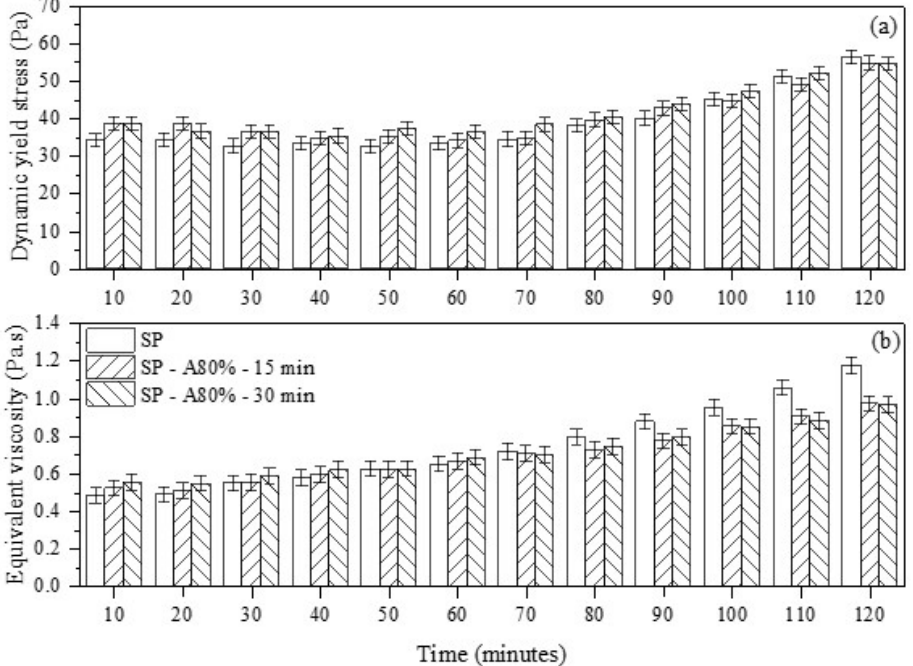
Figure 9. Dynamic yield stress (a) and equivalent viscosity (b) of the pastes over time.